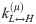
Accuracy of VB-DCMM in detecting internal states under various conditions of kL↔H(μ) and γ(1)↔(2) with Tobs/Δt = 8800.(A) The color bar denotes the accuracy of analysis in terms of 〈χ〉 under varying kL→H(2),kH→L(2) with K = 2, kL→H(1)Δt=0.05, kH→L(1)Δt=0.05, and γ(1)→(2)Δt = γ(2)→(1)Δt = 0.001. (B) 〈χ〉 under varying γ(1)→(2) and γ(2)→(1) with K = 2, kL→H(1)Δt=kH→L(1)Δt=0.05,kL→H(2)Δt=0.00625,kH→L(2)Δt=0.0125. 〈χ〉 was calculated by averaging over the results from analysis of 100 traces in each condition. The panels on the right show the relation between the value of 〈χ〉 and pairs of Dint and Dconf values which are evaluated at varying kinetic parameters. Results from the analysis over the data with the same parameters but different length of time trace (or different number of data points Tobs/Δt = 2200, 4400) are provided in S4 Fig.